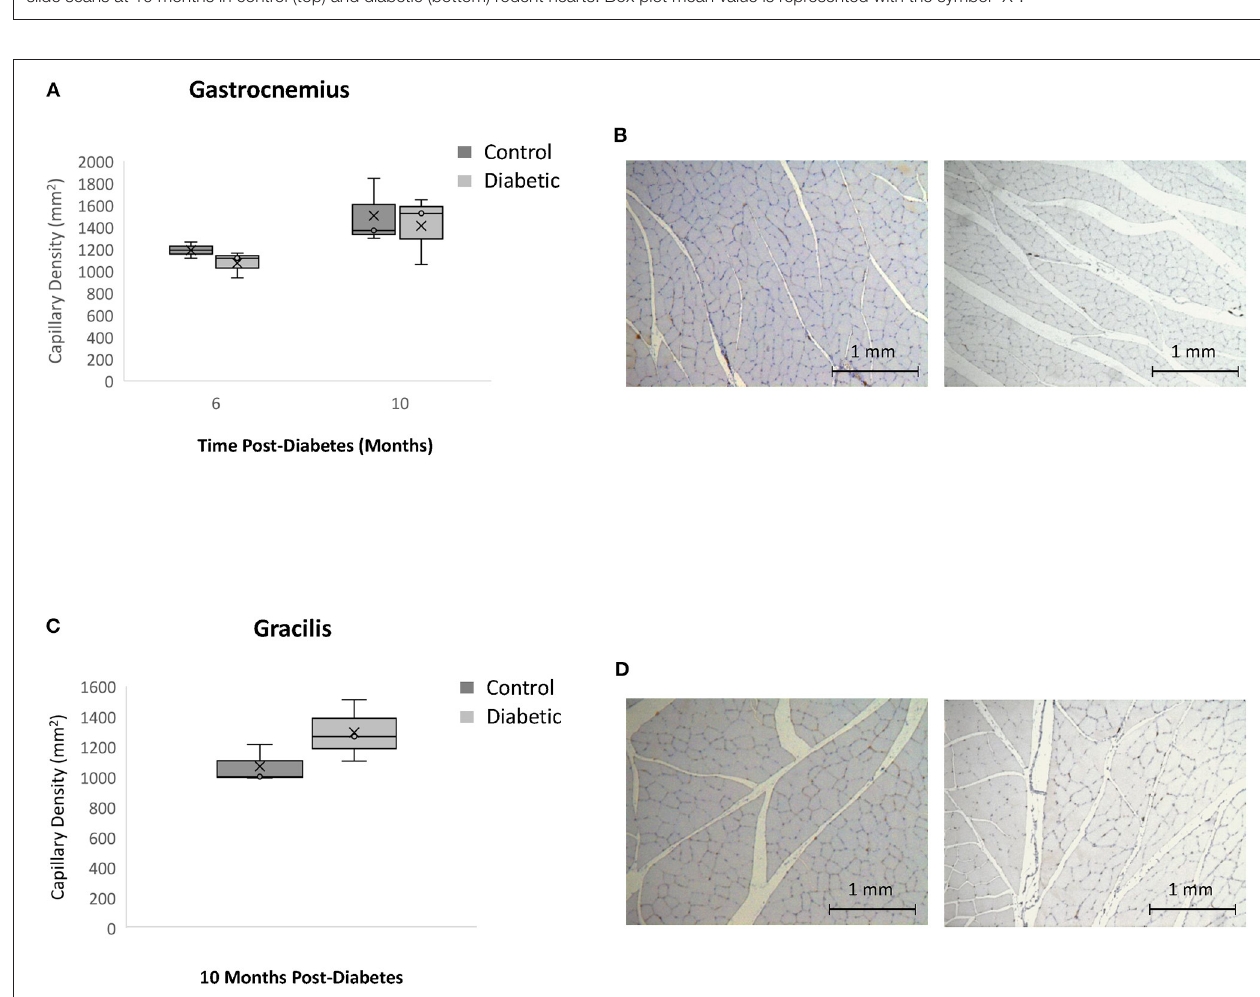
FIGURE 9 | surface area coverage on stained heart sections; shown on the right are slide scans of the LV at 10 months post-diabetes in control (top) and diabetic (bottom) rats. (D) Myocardial capillary density quantified as the number of vessels per mm 2 of tissue on stained heart sections; shown on the right are slide scans of the LV at 10 months post-diabetes in control (top) and diabetic (bottom) rats. Arrow shows a small area of reduced capillary density. (E) Cardiomyocyte cross-sectional area quantified at 6 months ( n = 2 control, n = 3 diabetic) and 10 months post-diabetes ( n = 2 control, n = 3 diabetic); shown on the right are H&E